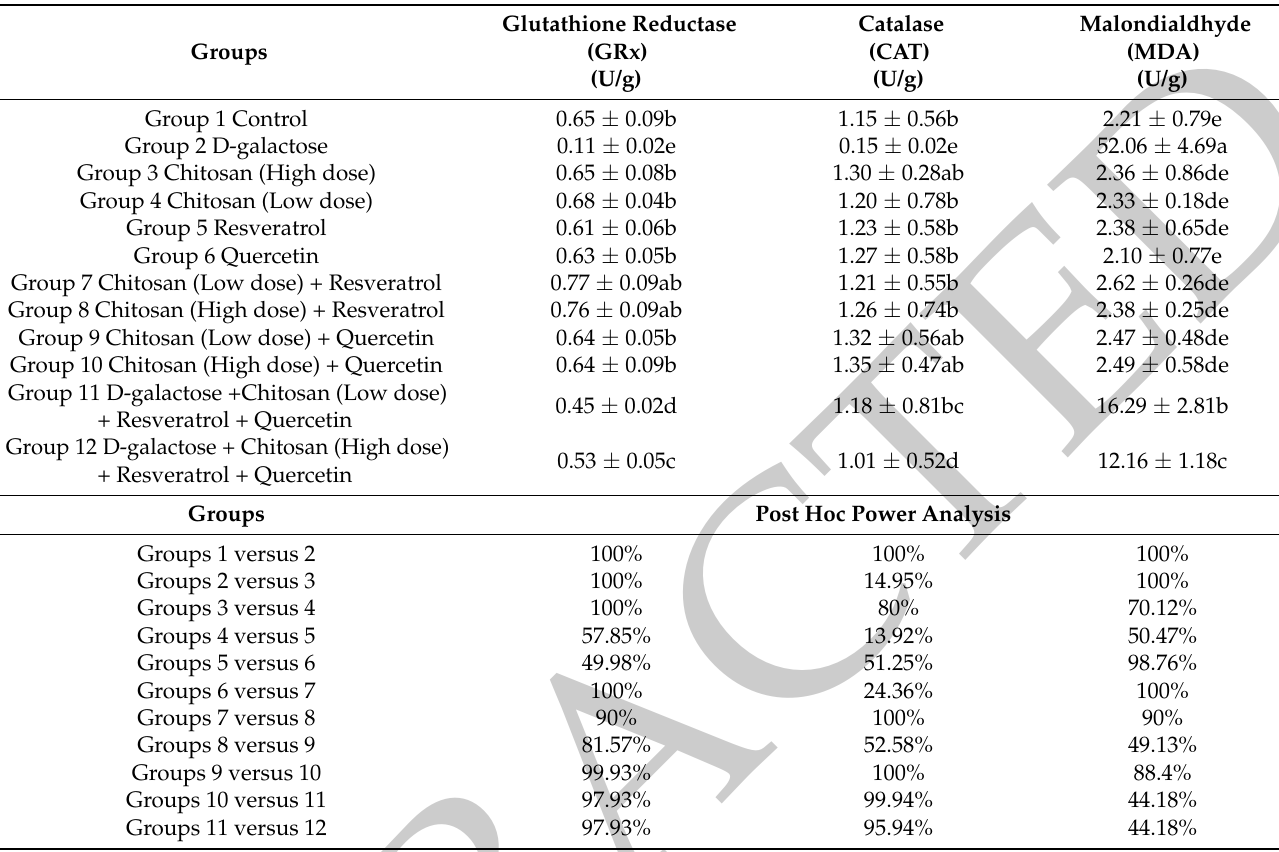
Table 1. Effect of D-galactose, Chitosan nanoparticles, Resveratrol, Quercetin, and their combination on antioxidant enzyme: Catalase, Glutathione reductase, and Malondialdhyde (in Brain homogenates) of male mice (mean ± SE).